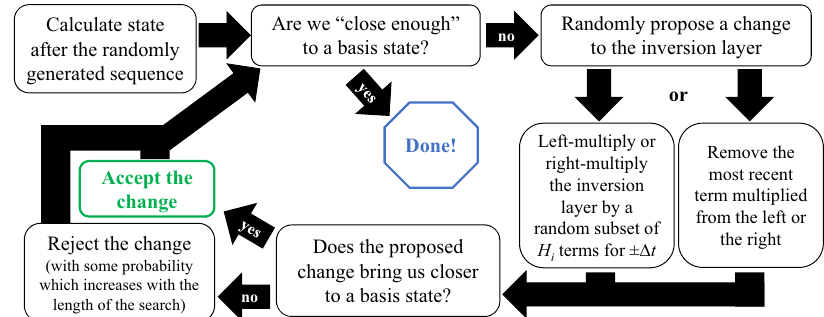
Fig. 3 Illustrative fl owchart for the approximate unitary compilation procedure. The time duration ± Δ t refers to the time and direction of each individual step in the sequence, i.e., the desired total simulation time τ divided by n , the total number of steps in the sequence.